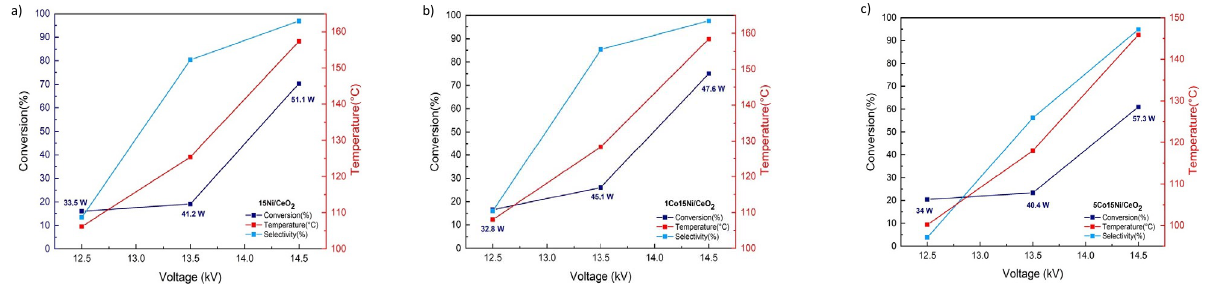
Figure 9. CO 2 conversion, Temperature measured and CH 4 selectivity of ( a ) 15Ni/CeO 2 , ( b ) 1Co15Ni/CeO 2 , ( c ) 5Co15Ni/CeO 2 , catalysts as function of voltage.